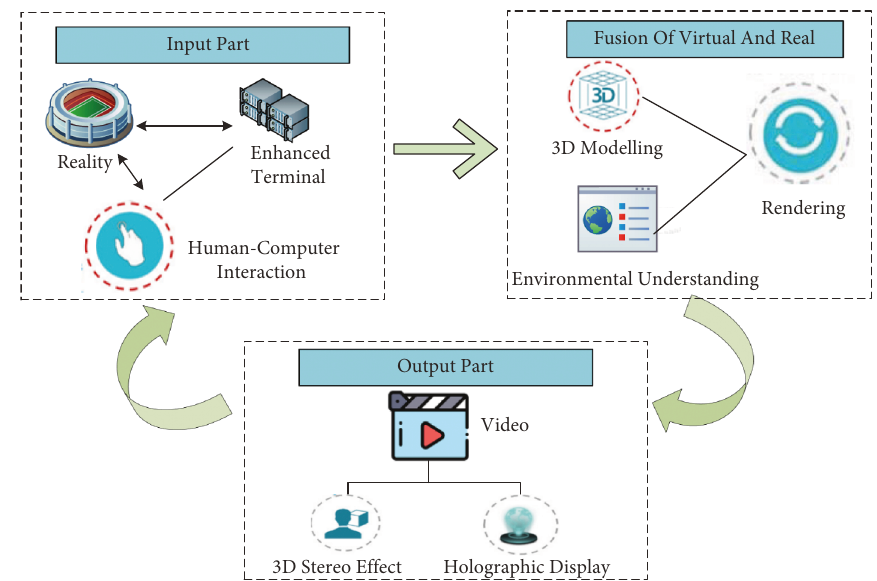
Figure 7: Comprehensive application of neural network and virtual reality